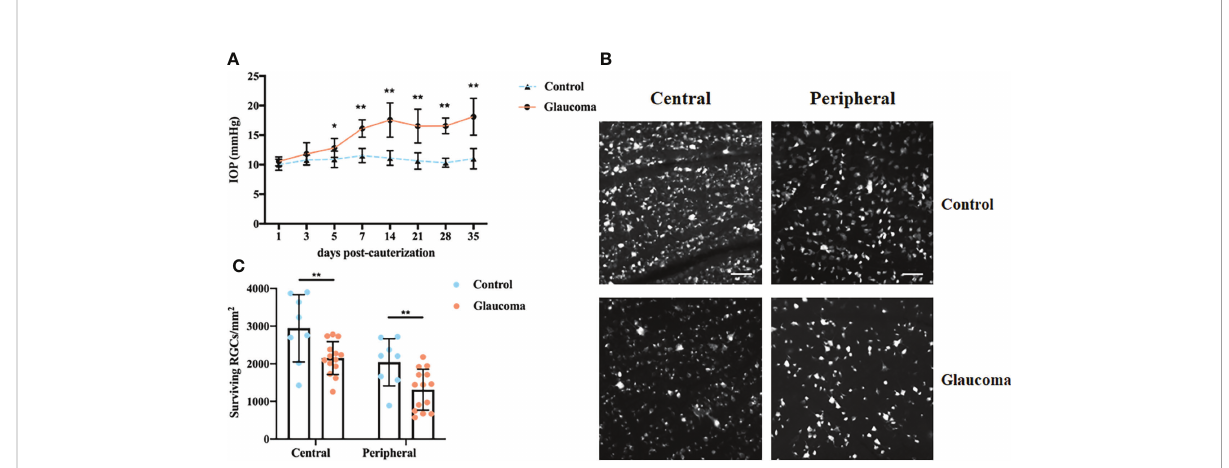
FIGURE 1 IOP changes and FluoroGold labeling of RGCs in control and glaucomatous rats. (A) Changes in IOP after inducing chronic ocular hypertension through EVC. (B) FluoroGold labeling of surviving RGCs in retinas 5 weeks after EVC. Images (scale bar, 50 m m) from the same retina in central and peripheral parts are showed. (C) Quantitative analysis of RGCs in control and glaucomatous eyes. The results are expressed as the mean ± SD. *P<0.05, **P<0.001. IOP, intraocular hypertension; RGC, retinal ganglion cell; EVC, episcleral vein cauterization; SD, standard deviation.